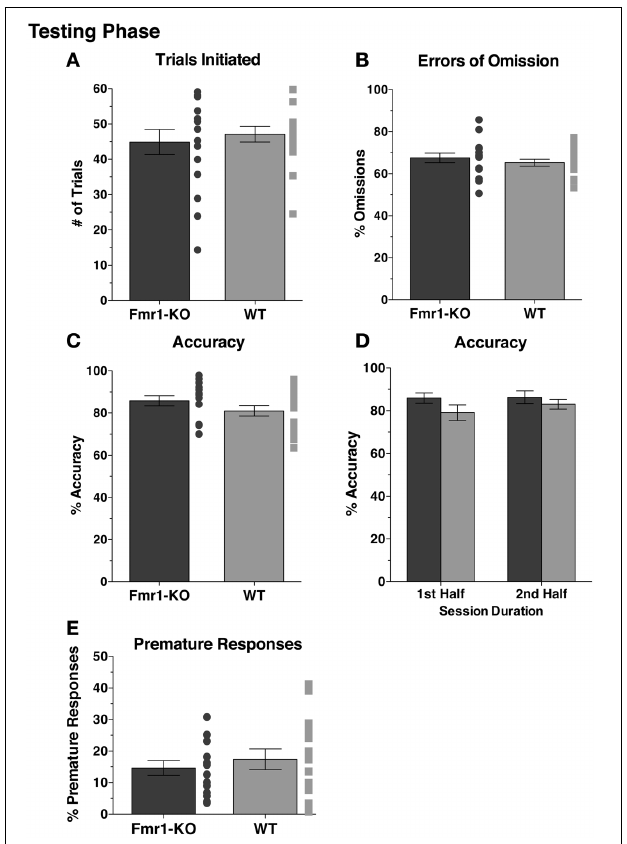
FIGURE 5 | Fmr1 -KO mice show no deficits in sustained attention and demonstrate no difference in impulsive behaviors during the 5CSRTT SD1 testing phase. During the 5CSRTT testing phase, with stimulus duration of 1s (SD1), Fmr1 -KO and WT mice initiated similar numbers of trials (A) and committed equal errors of omission (B) . Accuracy for the task was comparable between the two groups (C) . Accuracy for either group did not change during the 1st and 2nd half of the session (D) . Premature responding (E) was equal between Fmr1 -KO and WT mice.